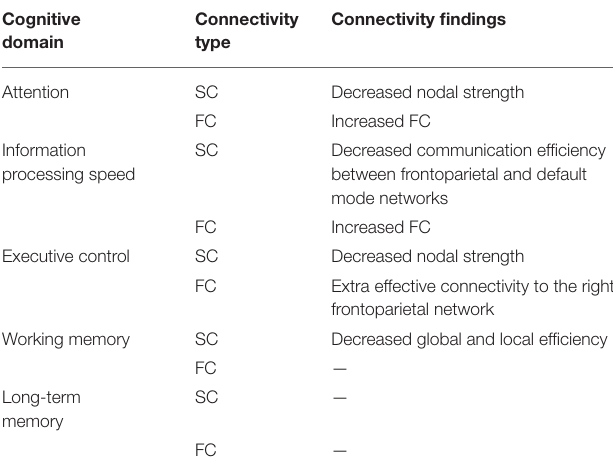
TABLE 2 | Findings of SC damage and FC alterations of the frontoparietal network across cognitive domains in